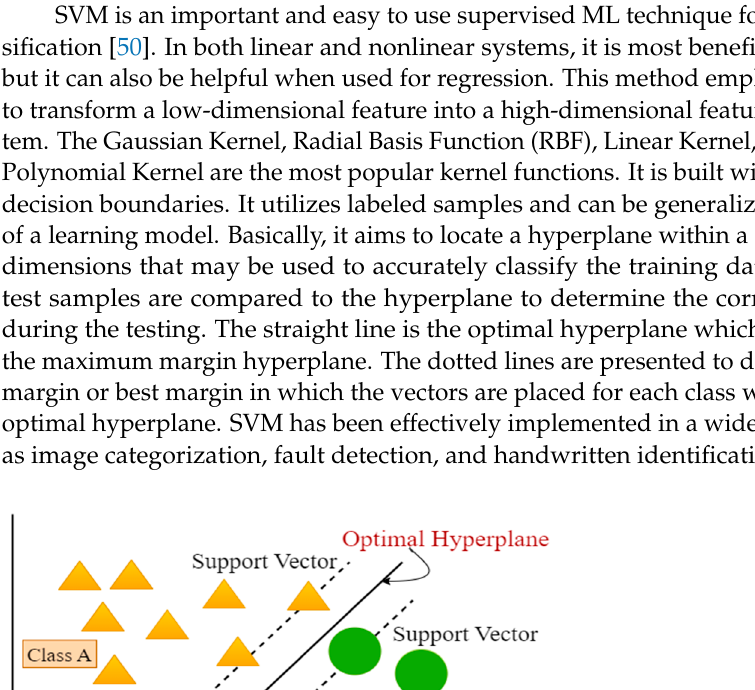
Figure 4. Basic structure of DT. 3.3.3. KNN To handle problems of classification and regression, KNN is utilized as a supervised ML method [32]. For classification, at first, it calculates the number of nearest neighbors. Then, calculate the distance of testing observations with all training data using Euclidean distance. After that, it selects possible shortest distance observations from the testing point and calculates the probability of all shortest observations. In order to properly categorize a new data point, it makes use of all of the training data previously obtained. It assigns